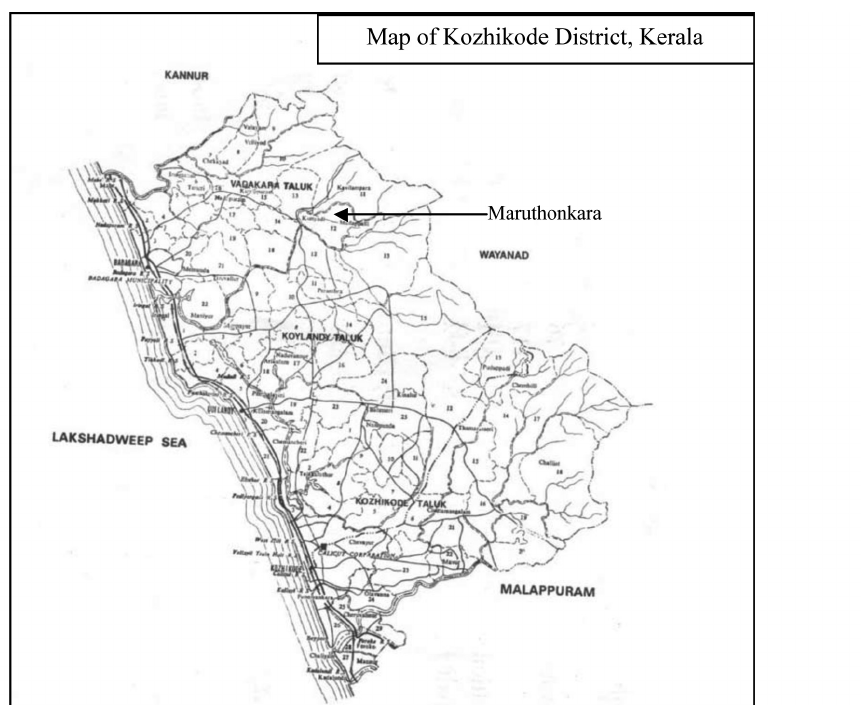
Fig1: Location of Maruthonkara village in Kozhikode District